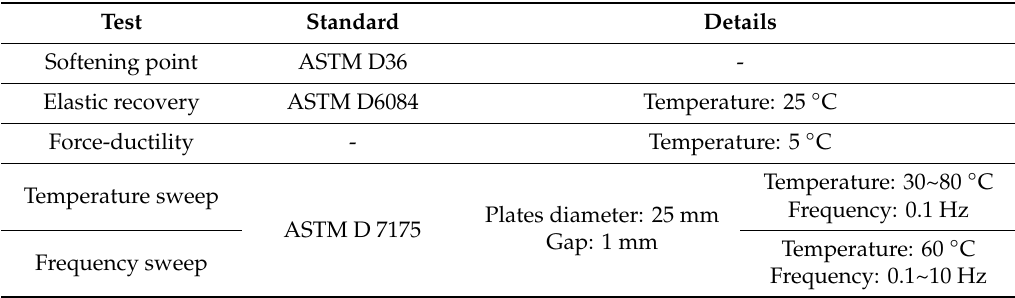
Table 3. Technological tests, normative standards, and details performed on bitumen